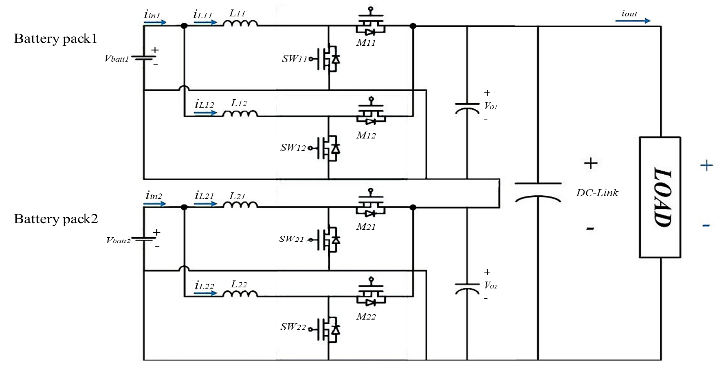
Figure 5. Synchronous bidirectional boost converter.